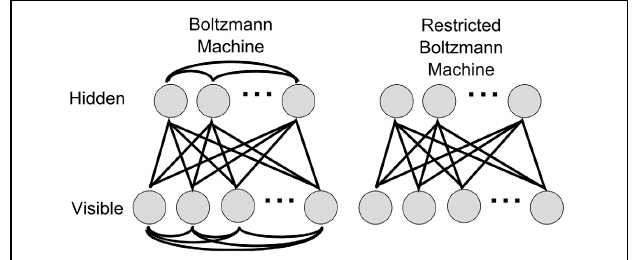
FIGURE 1 | Boltzmann and Restricted Boltzmann Machines. A Boltzmann machine is fully connected within and between layers, whereas in a RBM, the lateral connections in the visible and hidden layers are removed. As a result, the random variables encoded by hidden units are conditionally independent given the states of the visible units, and vice